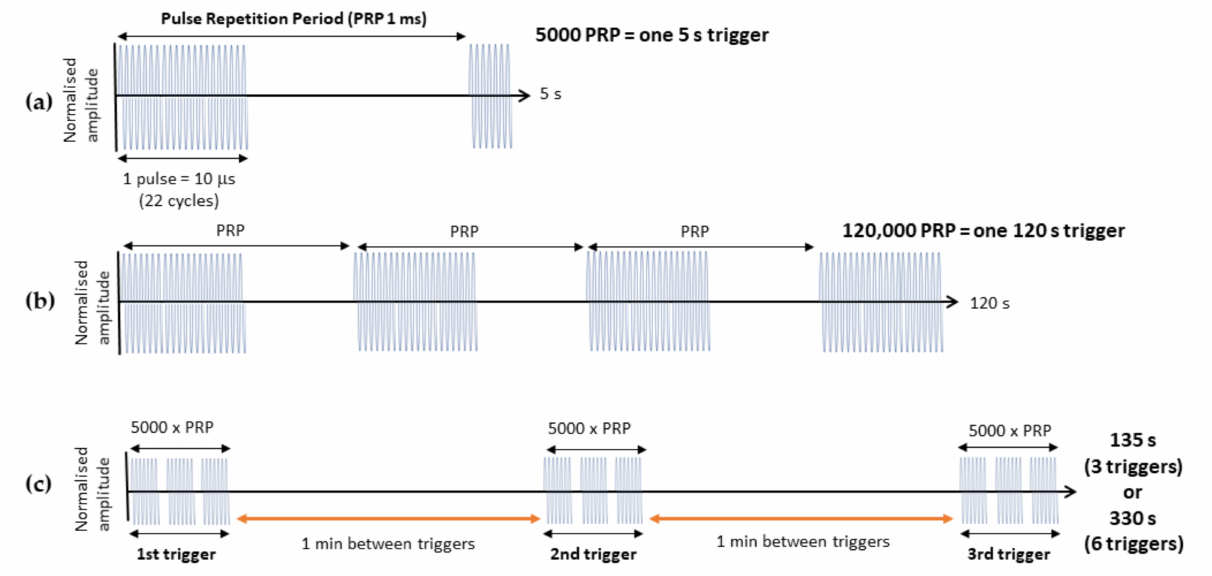
Figure 1. Schematic of ultrasound parameters. ( a ) One pulse consists of ~22 cycles, generated from a 2.25 MHz transducer with a pulse length of 10 µ s. Since the PRF is 1 kHz, the pulse repetition period (PRP) is 1 ms, and hence with a pulse length of 10 µ s, the duty cycle is 1%. A 5 s sonication time with these parameters will deliver 5000 PRPs and is termed one 5 s trigger. ( b ) Increasing the ultrasound trigger from 5 s to 120 s delivers 120,000 PRP and is termed one 120 s trigger. ( c ) Multiple triggers were created from the 5 s trigger sequence with a one min wait time between each